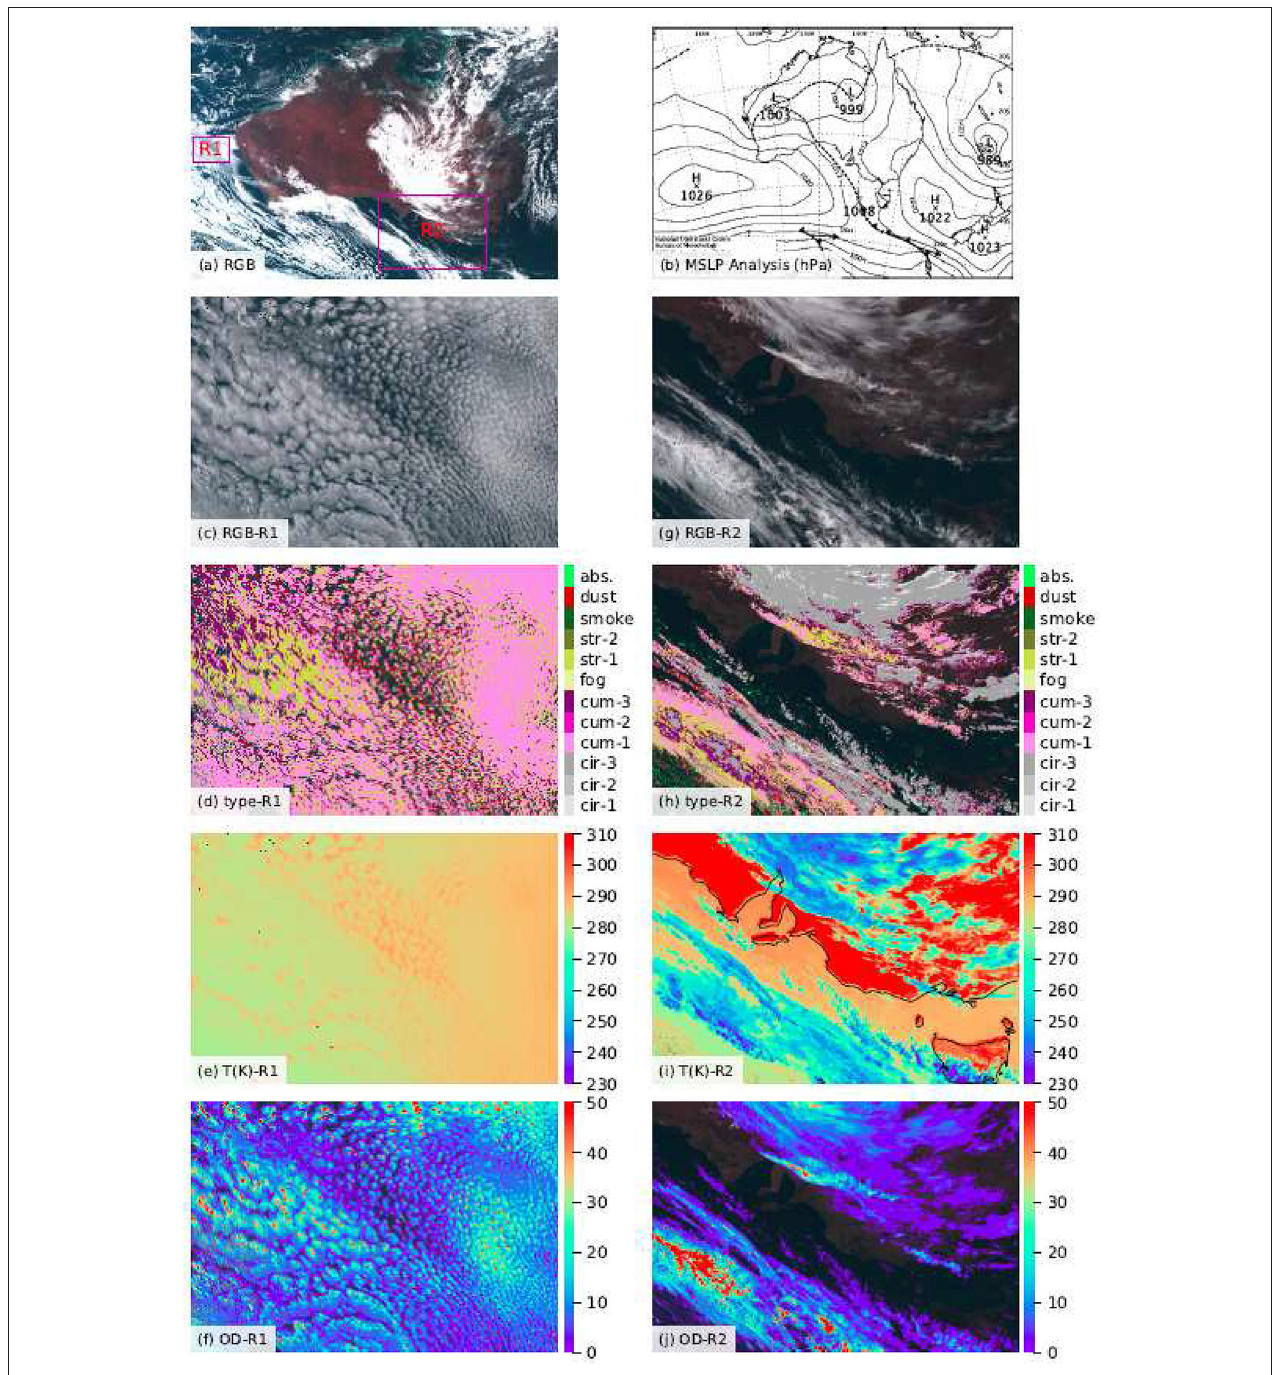
FIGURE 8 | Example cloud classification and optical depth retrieval results, obtained at 00:00UTC on 31 Dec 2015. (a) Is RGB composite for the whole Australian region with AHI band 3 (0.64 µ m , red), band 2 (0.51 µ m , green) and band 1 (0.47 µ m , red). The two rectangles, labeled R1 and R2 respectively, mark two sub-regions that are examined in detail below. (b) Shows the mean sea level pressure (MSLP) analysis at 00:00 UTC (source: Australia Bureau of Meteorology). (c–f) Are, respectively, the RGB composite, cloud classification, cloud-top-temperature and optical depth for sub-region R1. (g–j) respectively provide the same information as (c–f) , except for sub-region